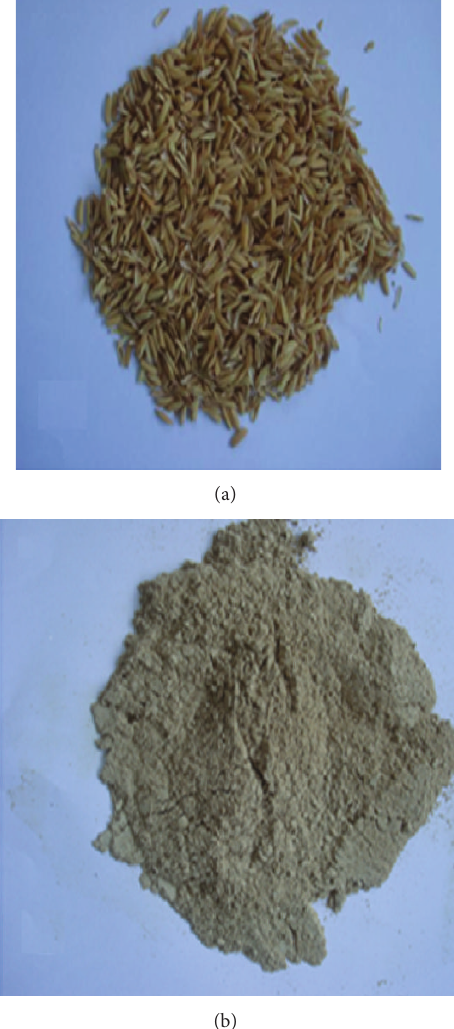
Figure 1: NaOH-treated RHF before (a) and after (b) grinding and